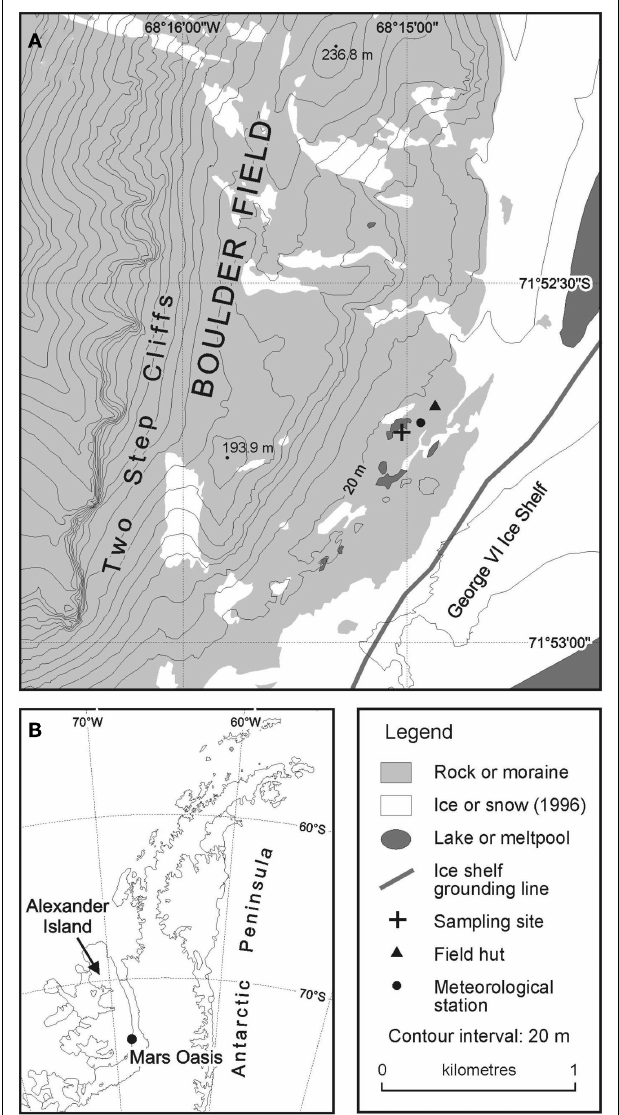
FIGURE 1 | Location of Mars Oasis (A) on theAntarctic Peninsula (B).